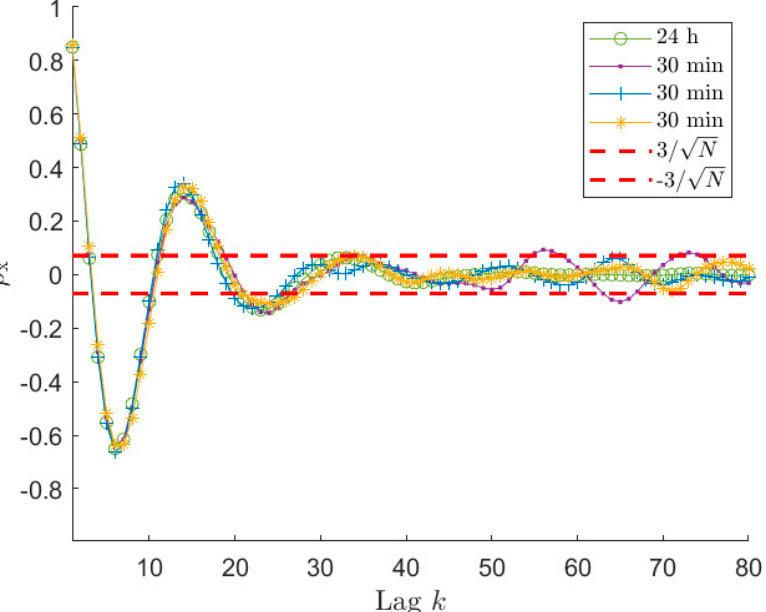
Figure 6. Normalised auto − covariance 𝜌 (cid:2934) curves for a signal 24 h long and three signals 30 min long. The ±3/√𝑁 range is related to the three 30 min long signals. These three signals have φ(cid:3549) between 25 and 27, depending on the time series.